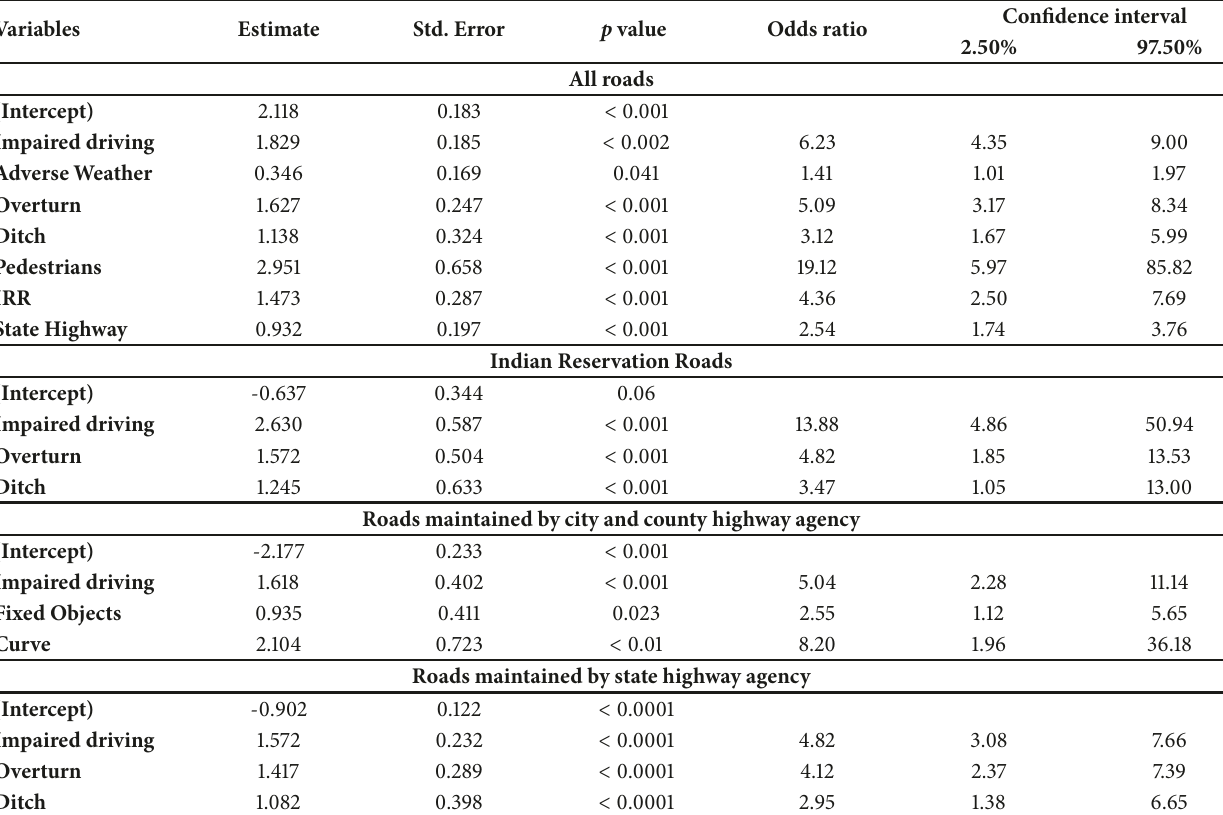
Table 3: Logistic regression: parameter estimates and odds ratios for all